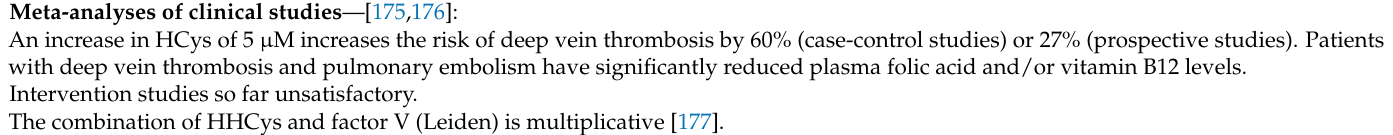
Table A3. Thrombophilia: venous thrombosis, embolism.